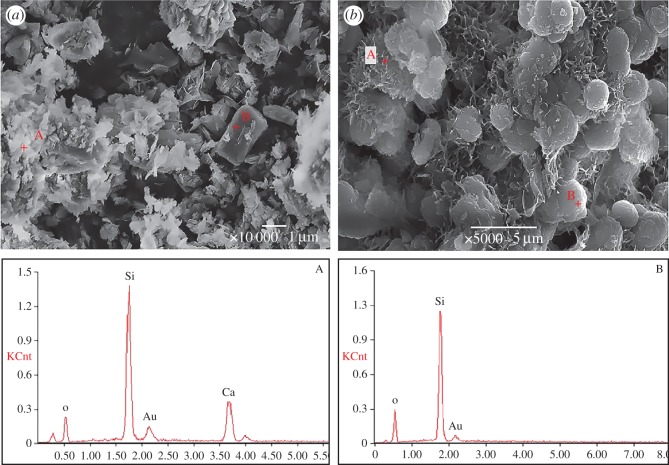
The SEM images and EDS data of quartz glass powder in 1 mol l−1 NaOH solution with Ca(OH)2 at 80°C, (a) with 1 mol l−1 LiNO3; (b) with 2 mol l−1 LiNO3.